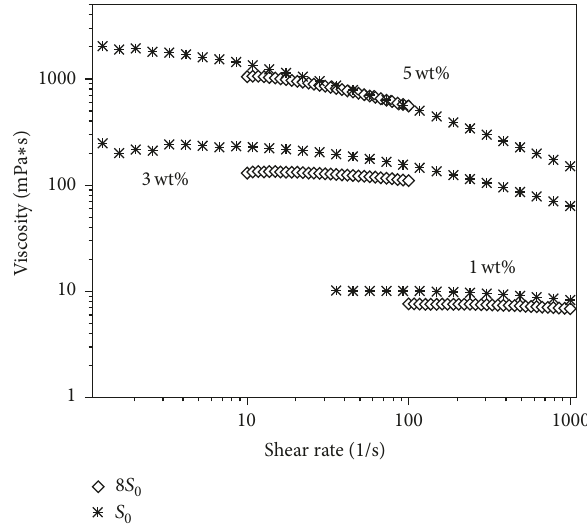
Figure 7: Influence of initial tensioactive concentration on shear